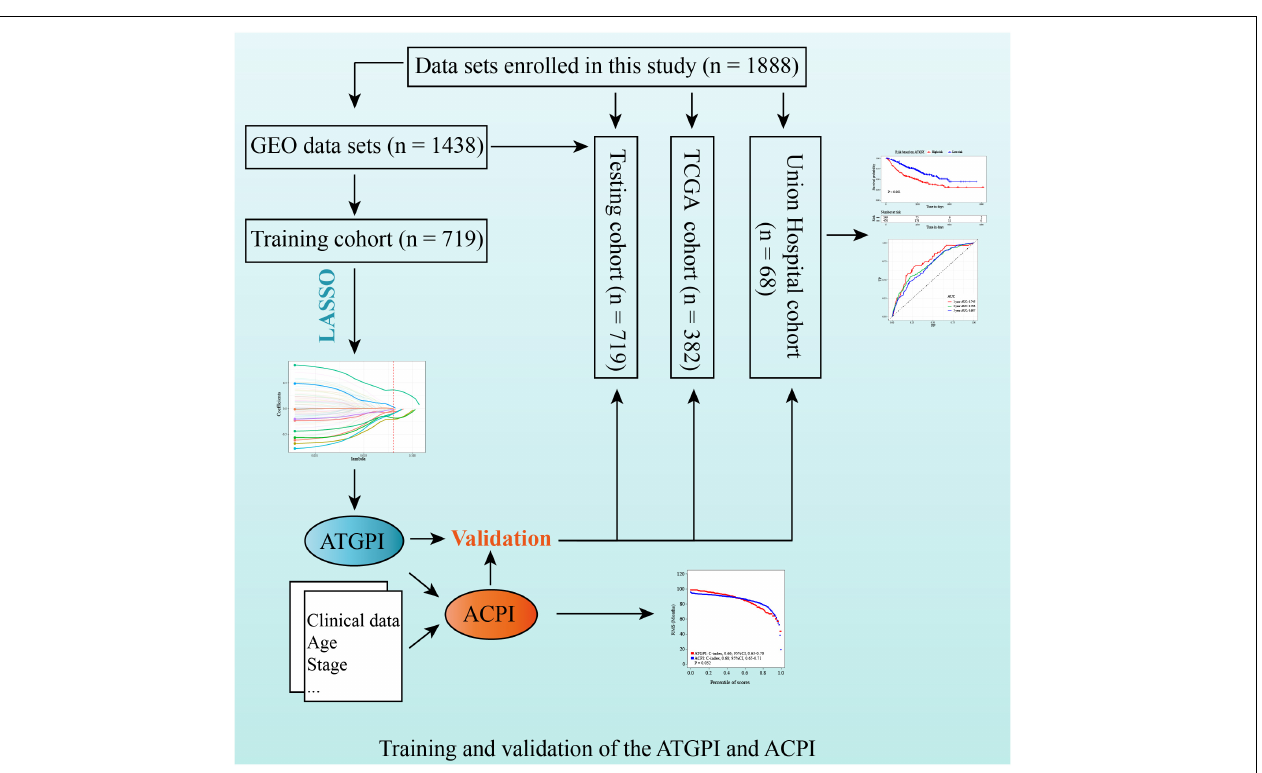
FIGURE 1 | Study design for the construction and validation of the autophagy-related gene pair index (ATGPI) and autophagy clinical prognostic index (ACPI) in early-stage lung adenocarcinoma.